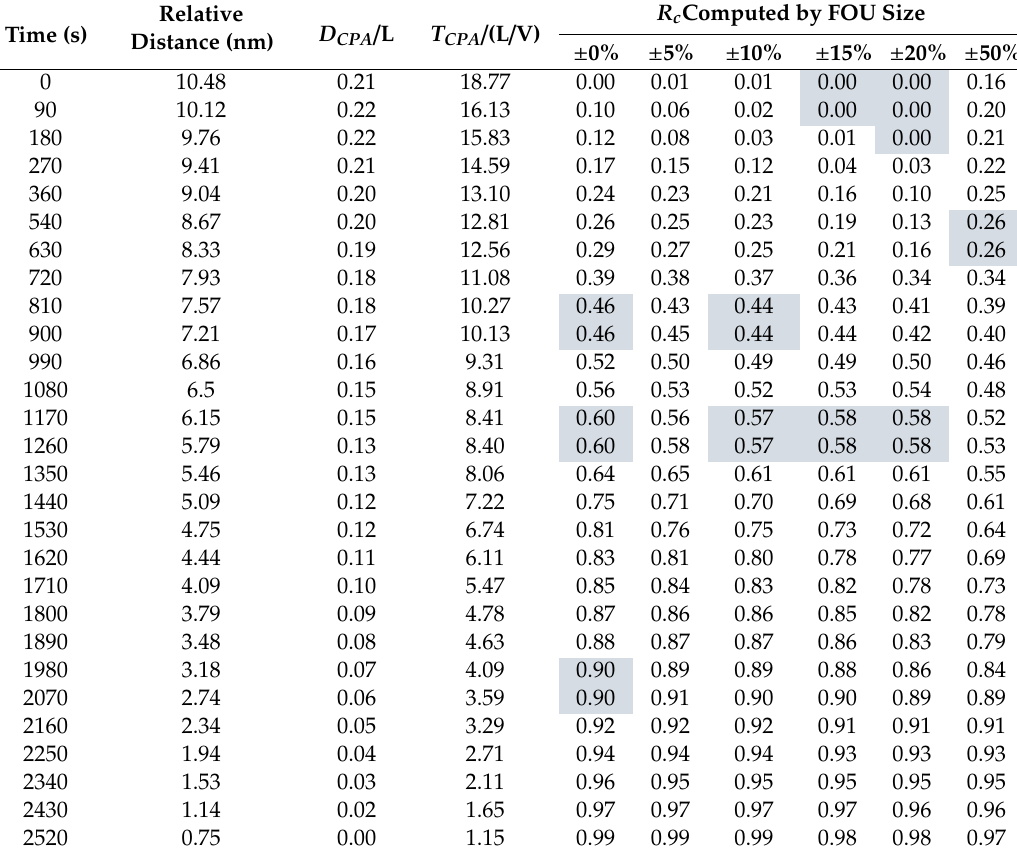
Figure 15. Linear 𝑅 (cid:3030) by time and relative distance. Figure 15. Linear R c by time and relative distance. Table 4. Linear R c computed by di ff erent FOU size: background color is identical R c Table 4. Linear 𝑅 (cid:3030) computed by different FOU size: background color is identical 𝑅 (cid:3030) .